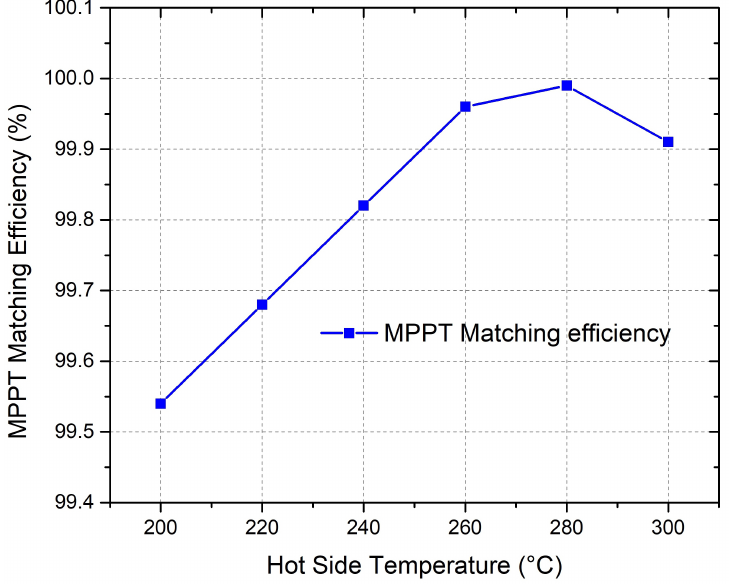
Figure 22. MPPT matching efficiency at different hot-side temperatures for the proposed